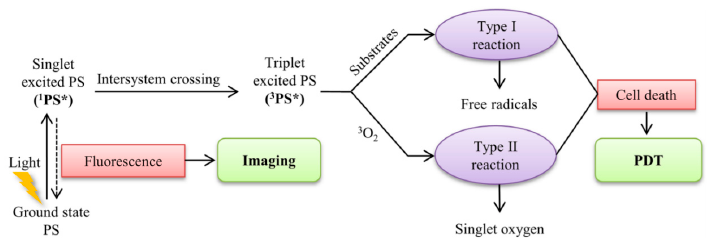
Figure 1. The schematic illustration of a typical photodynamic reaction (Reproduced with permission [18]).